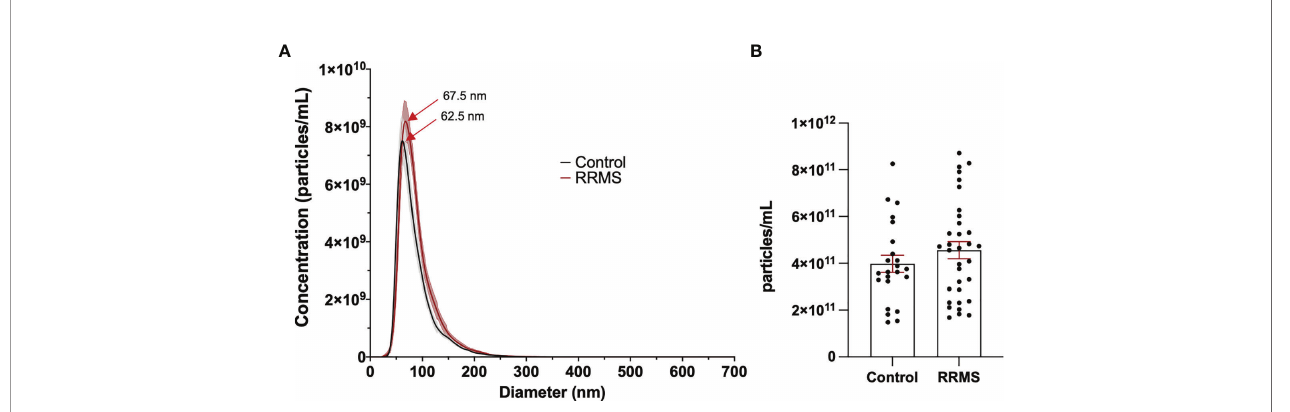
FIGURE 2 | Comparison of EVs in control and RRMS plasma. (A) NTA size distribution of control and RRMS plasma. (B) Comparison of EV concentration measured by NTA between control and RRMS